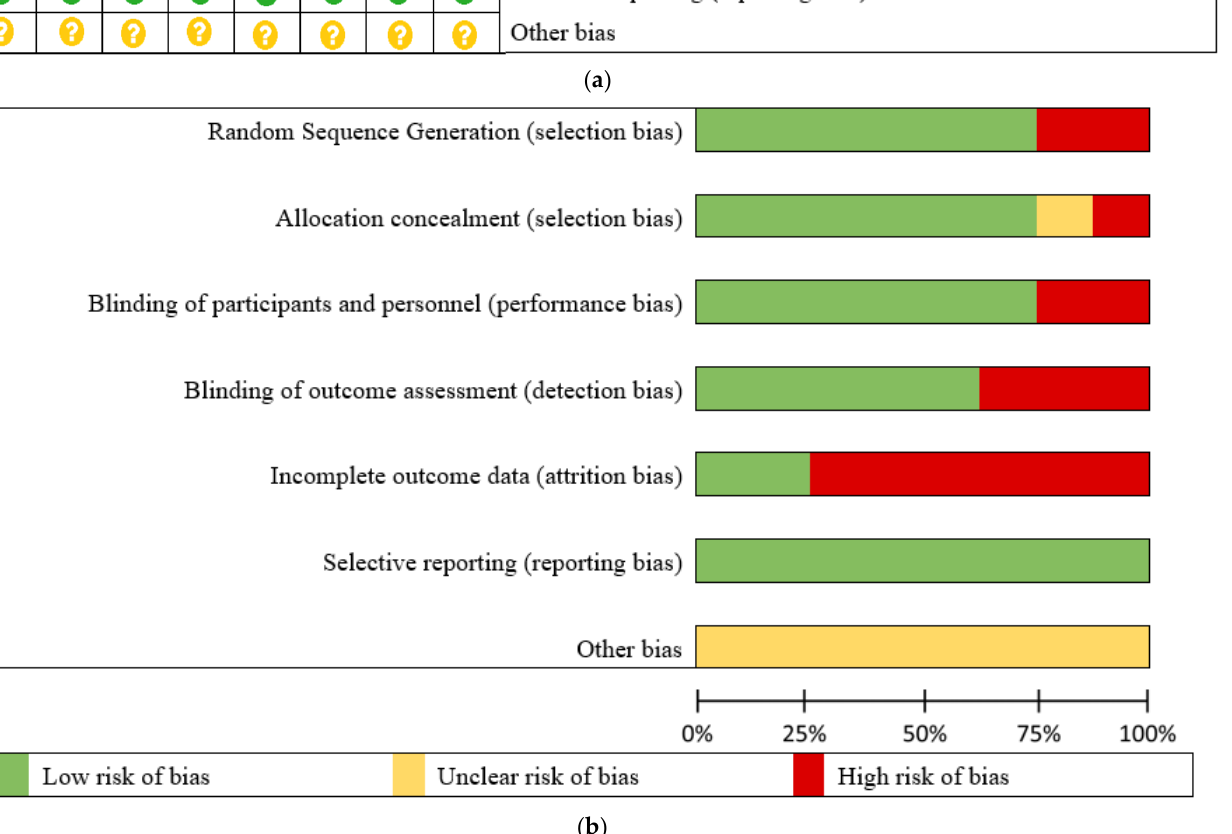
Figure 4. ( a ) Risk-of-bias summary: review authors’ judgments about each risk of bias item for each included study. ( b ) Risk-of-bias graph: review authors judgments about each risk-of-bias item presented as percentages across all included.